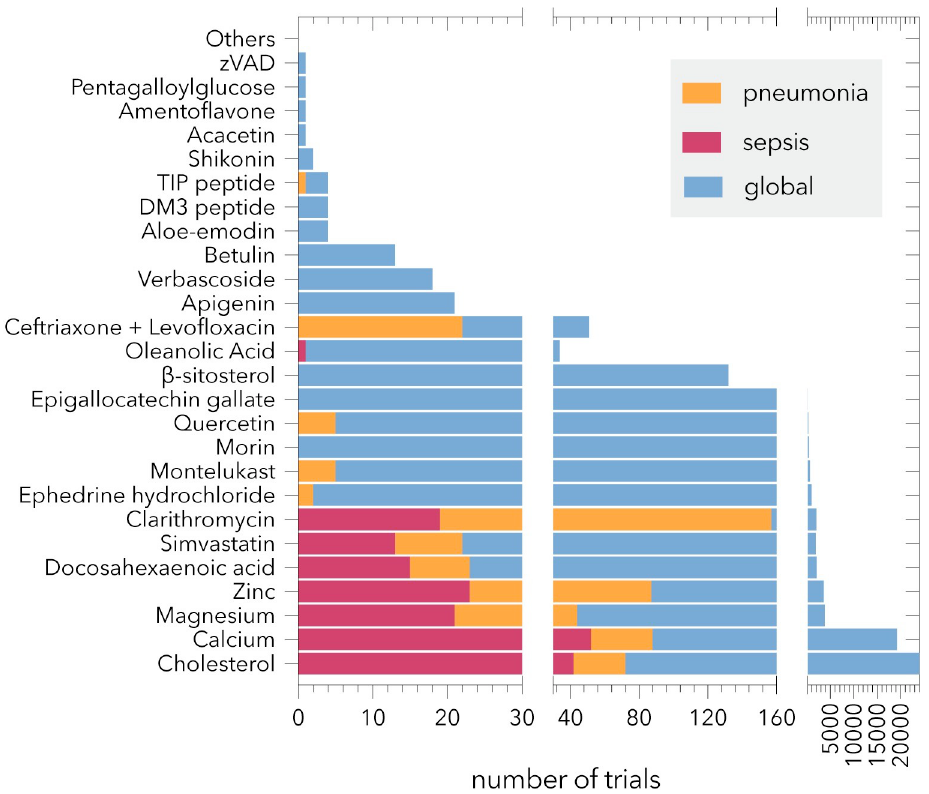
Fig 2. Number of papers indexed in MEDLINE as clinical trials related to the molecules included in this review. The molecules for which no clinical trials were found are grouped as “Others”. The X-axis is split in three parts.